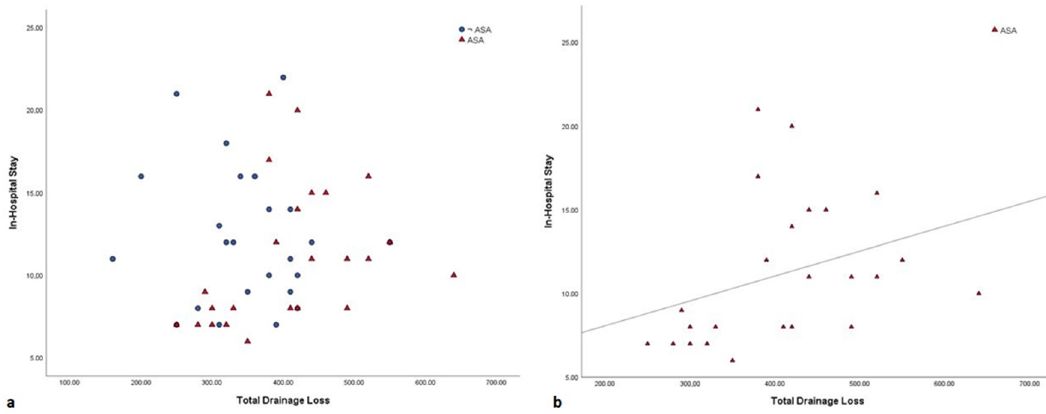
Figure 3. ( a ) Pearson correlation between total drain loss and in-hospital stay in all patients. ( b ) Pearson correlation between total drain loss and in-hospital stay in the Daily-on-ASA group (r 2 =